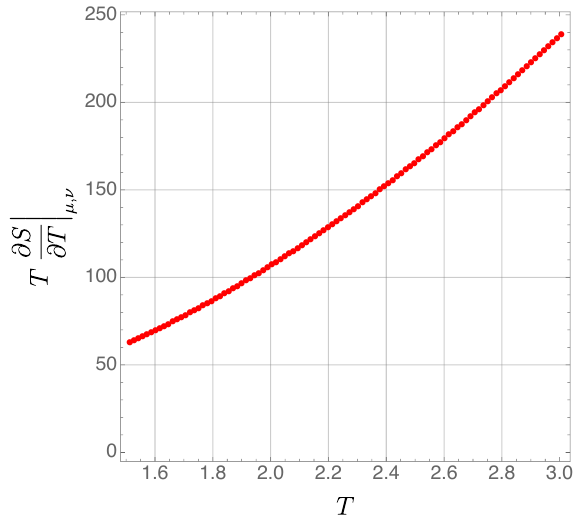
Figure 26 . Speci(cid:12)c heat of the new solutions as a function of their temperature, computed for (cid:12)xed boundary metric with (cid:22) = (cid:23) =